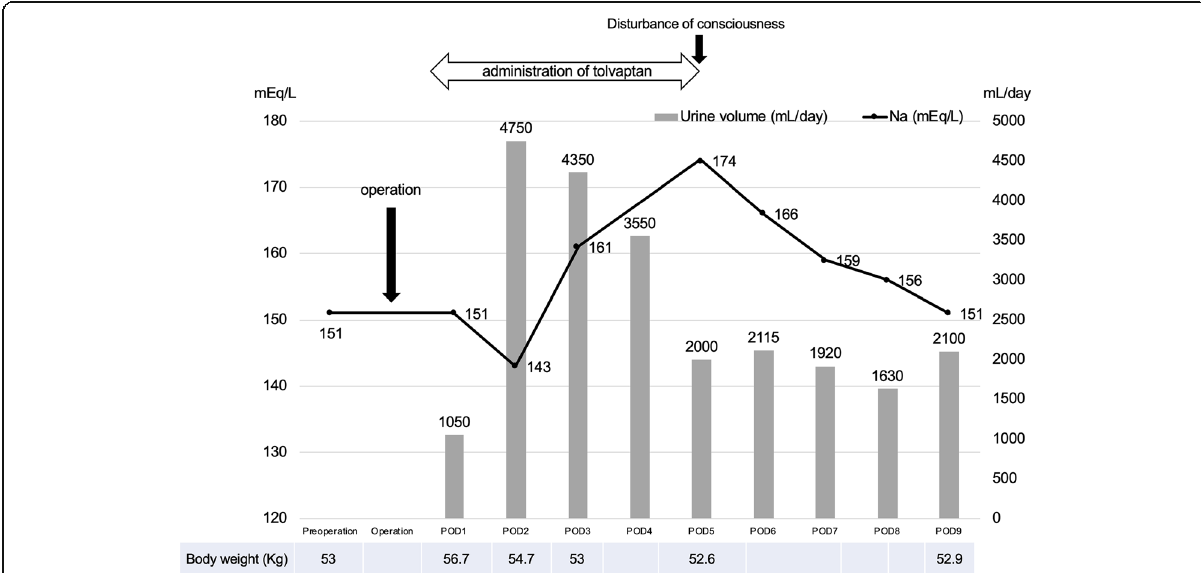
Fig. 4 Sequential changes in serum Na level, weight, and urine volume. Tolvaptan administration was started on POD 1; the Na level, which was 151 mEq/L before the surgery, rose to 174 mEq/L on POD 5. After terminating tolvaptan administration, the Na level gradually decreased and returned to the preoperative level by POD 9. The urine volume increased after tolvaptan administration to more than 4,000 mL/day. Body weight increased by 3.7 kg compared to the preoperative level; after tolvaptan administration, it returned to values similar to those observed before the